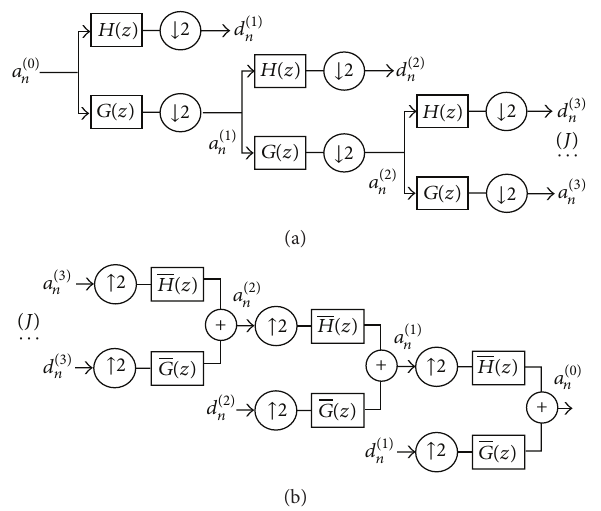
Figure1:Blockdiagramofthemultiresolutiondecompositionusing the wavelet transform, (a) analysis filter bank and (b) reconstruction filter